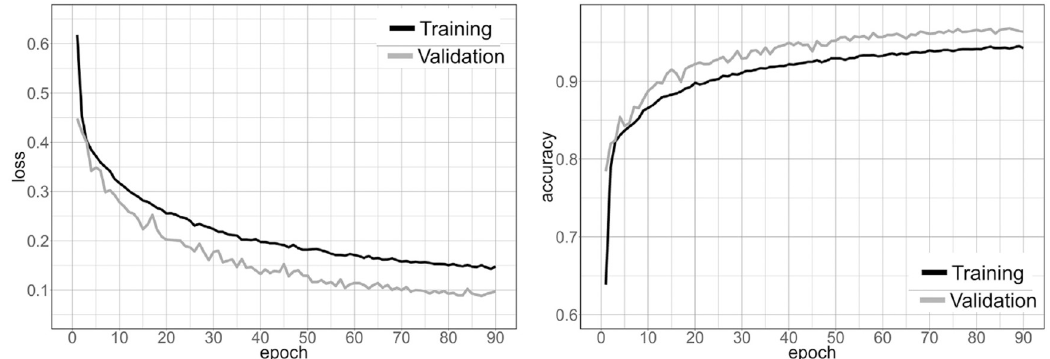
Fig 9. Over 90 epochs, the learning process for loss (on the left) and model accuracy (on the right) are shown. If dropout is used on the training data, the accuracy of the training data and the validation data will be different.